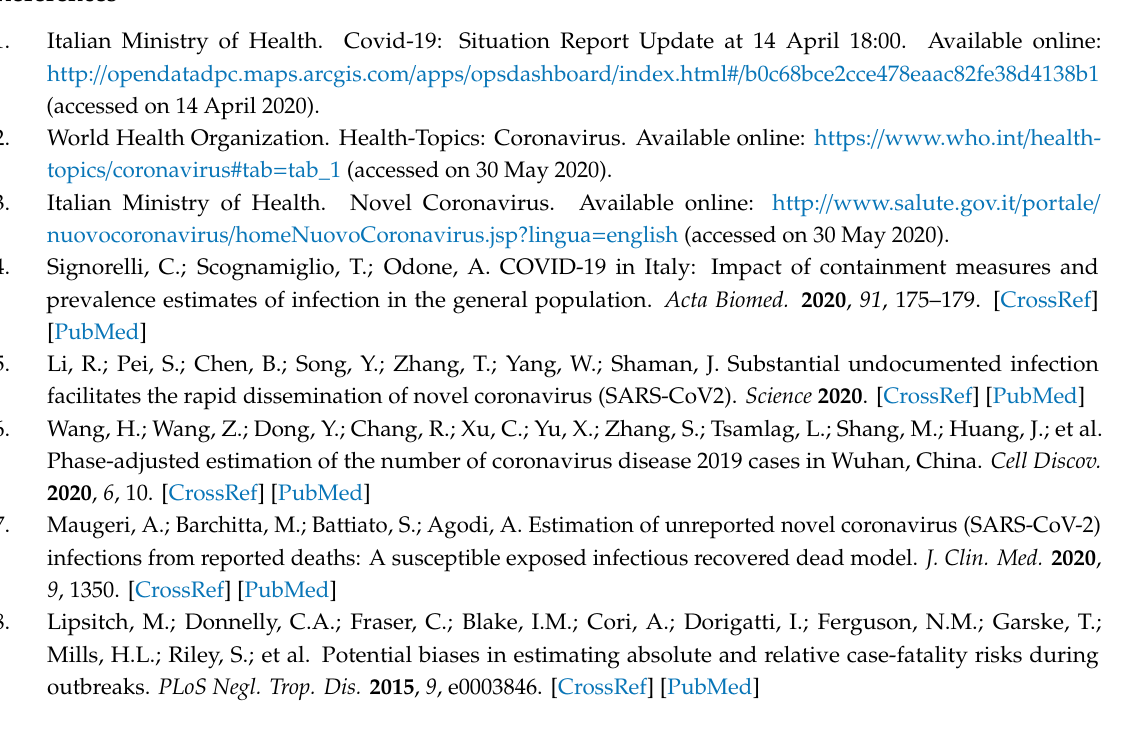
Figure S1: summary of data collection, model formulation and fitting, Table S1: extract of data on SARS-CoV-2 cases in Sicily (Italy), reported by the Italy’s Civil Protection from 24 February to 13 April 2020, Table S2: best-fitting parameters in the sensitivity